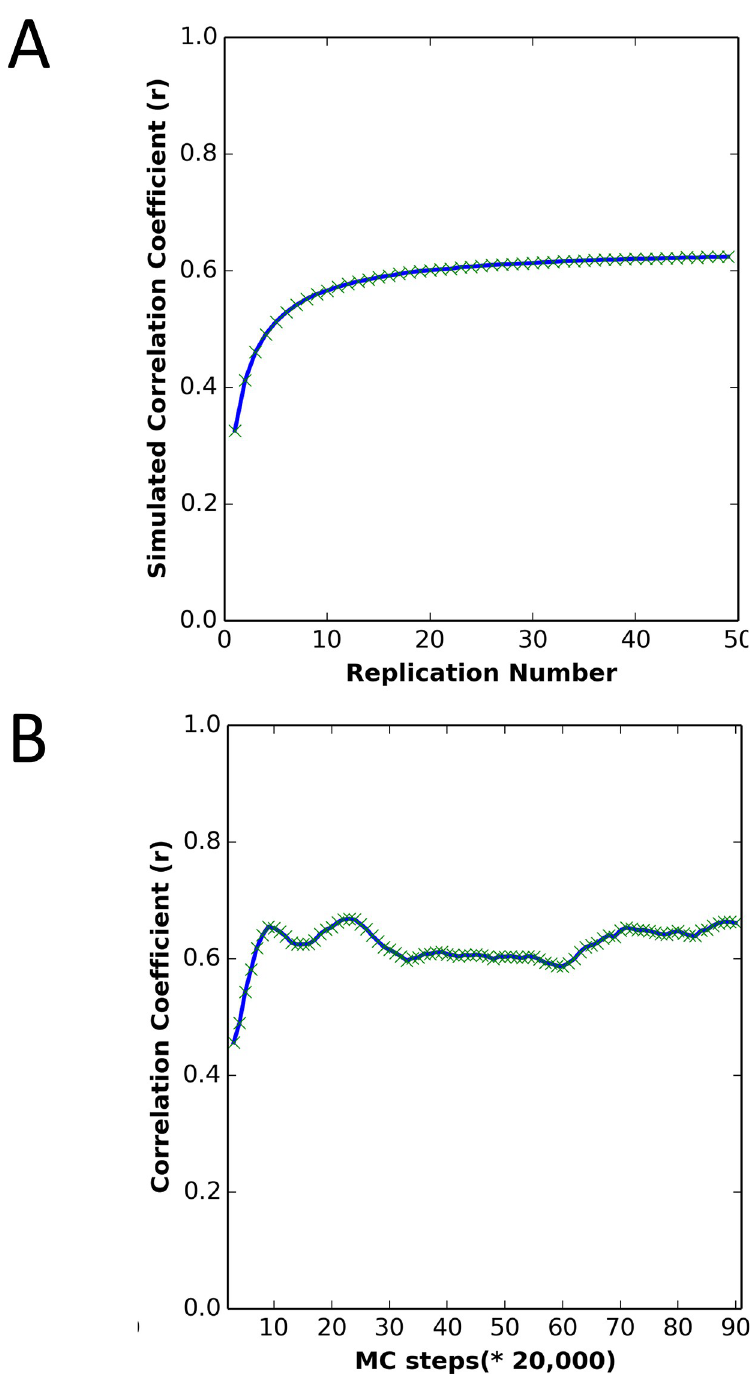
Fig 8. The effect of replication number and number of MC steps on simulation predictive power. (A) Correlation between simulated T m and experimental T m , averaging over different numbers of replications, for the DHFR wild type and mutants. Each protein was simulated for 2,000,000 MC steps, following MD minimization and equilibration at low temperature. (B) Correlation between the simulated T m and experimental T m with different numbers of MC steps and 50 replications, for the DHFR wild type and mutants. Each protein was first simulated for the number of steps given on the x-axis, and the next 100,000 steps were averaged in determining the simulated T m